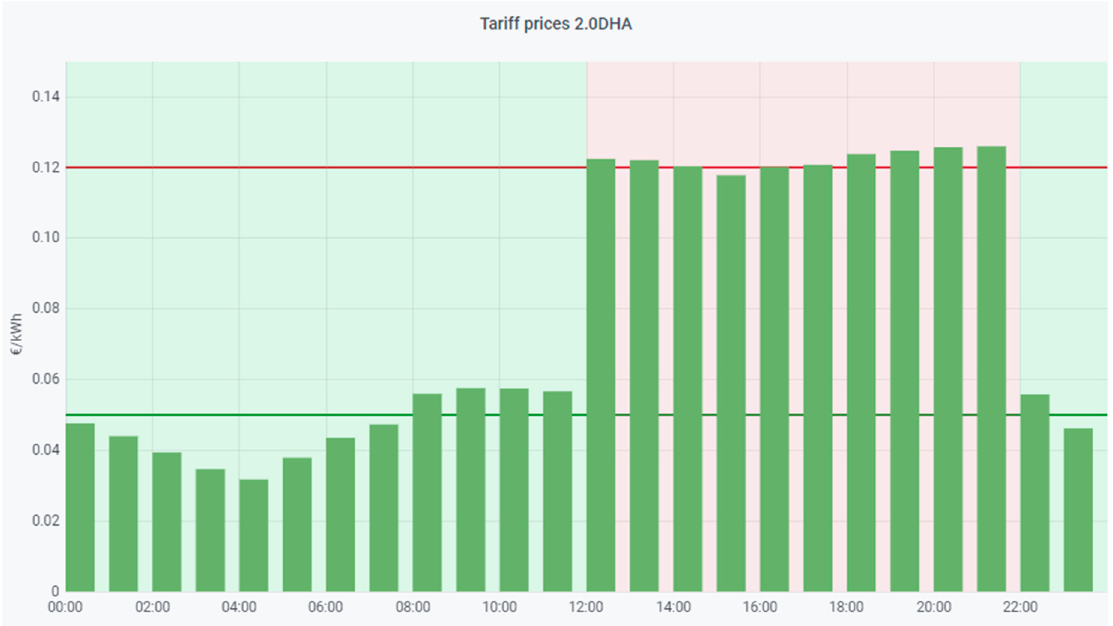
Figure 7. Example graph sent daily to the user with the next day’s prices (example of 11 December 2020).